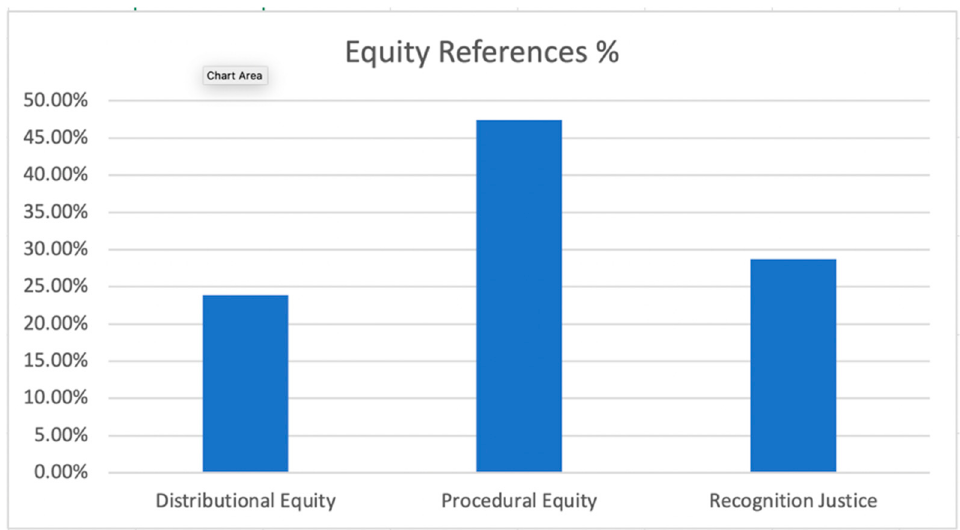
Figure 2. Equity references in RbD proposals.